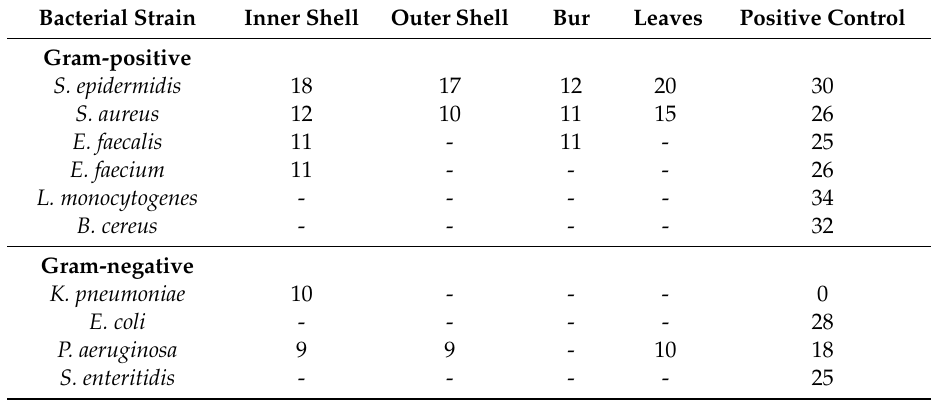
Table 4. Antimicrobial susceptibility (inhibition zones, mm) of multidrug resistant Gram-positive and Gram-negative bacteria to the ethanolic extracts from chestnut inner and outer shells, bur, and leaves.